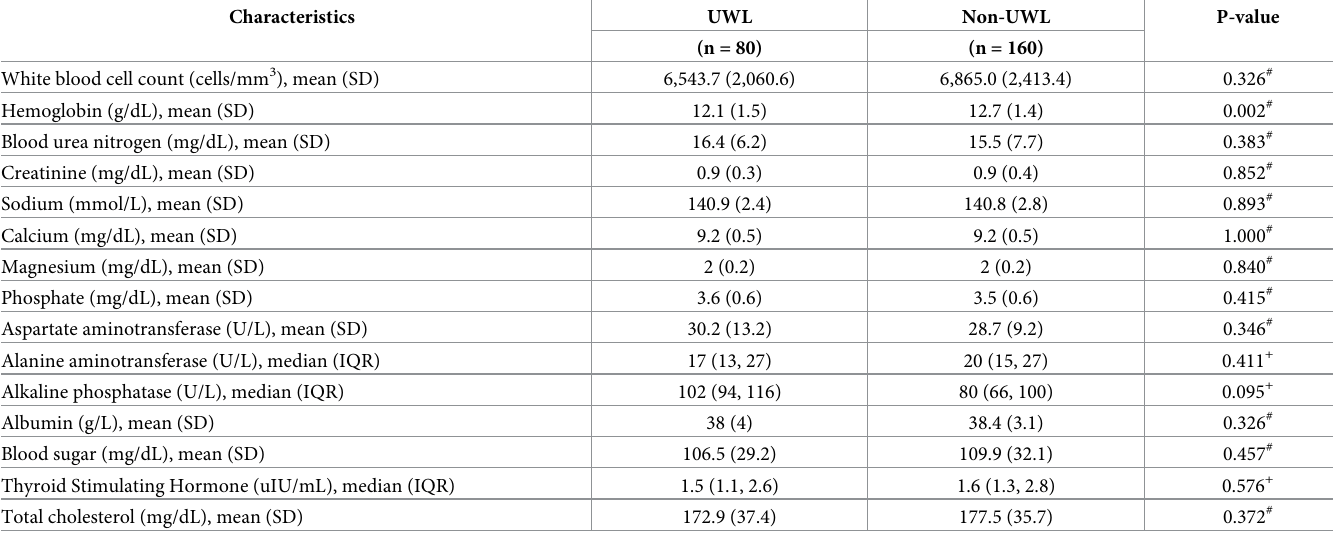
Table 5. Laboratory results among older patients in the geriatric outpatient clinic.